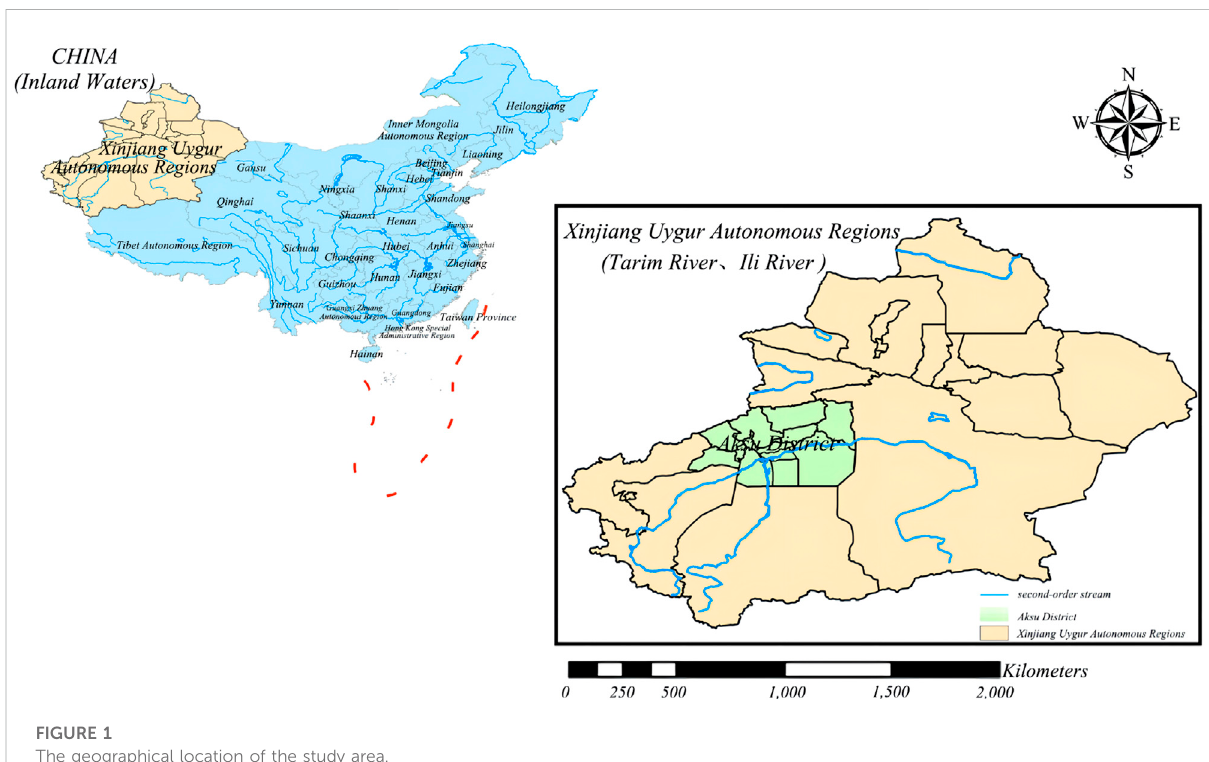
FIGURE 1 The geographical location of the study